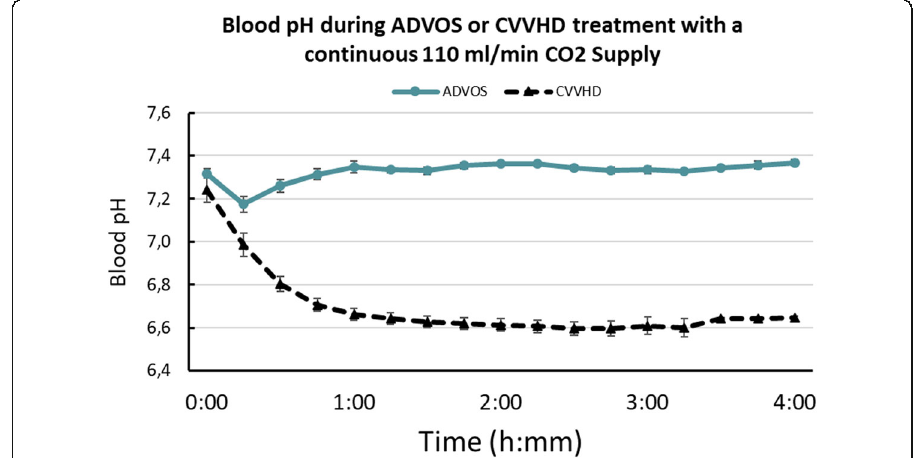
Fig. 4 Comparison of blood pH between a conventional hemodialysis (NIKKISO DBB-03) and the ADVOS system 4-h treatment under 110 ml/min CO 2 supply. Error bars represent SD. n =